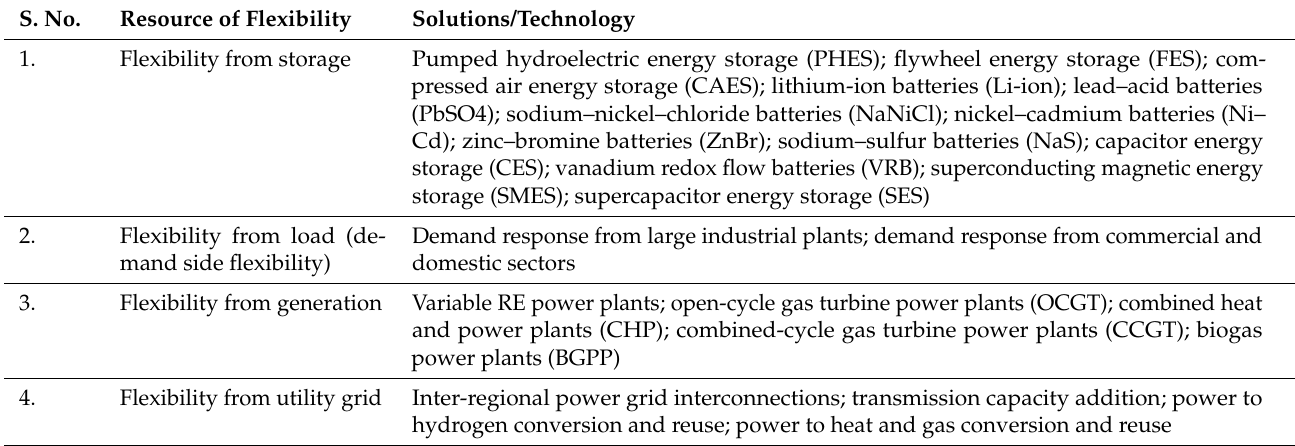
Table 5. Technological options and solutions for flexibility.